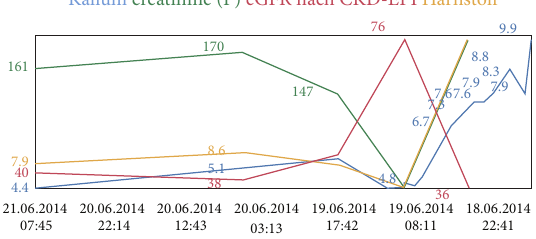
Figure2:Trendsofthelaboratoryparametersfromadmissiontothe emergency department until 2 days before discharge of the hospital: potassium, creatinine, GFR CKD-EPI, and